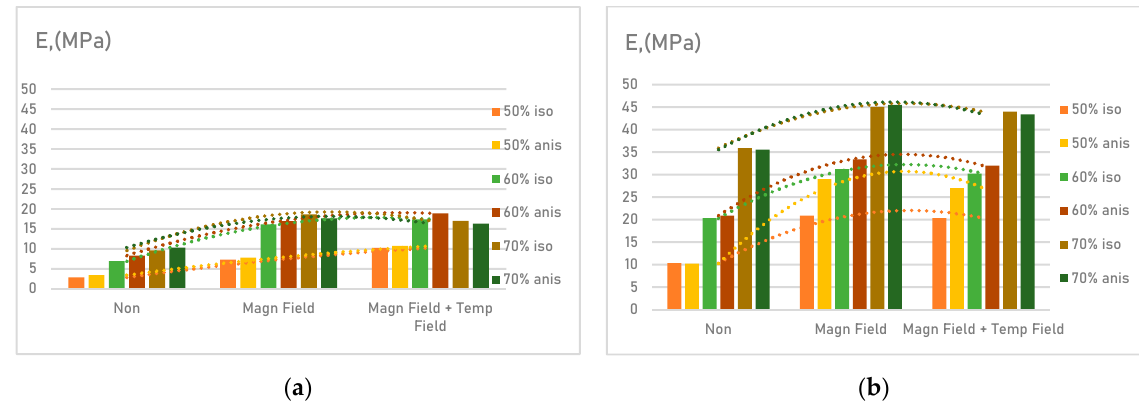
Figure 10. Assessment of MAE characteristics—elastic modulus: ( a ) samples with R-10 filler; ( b ) samples with atomized powdered iron filler.